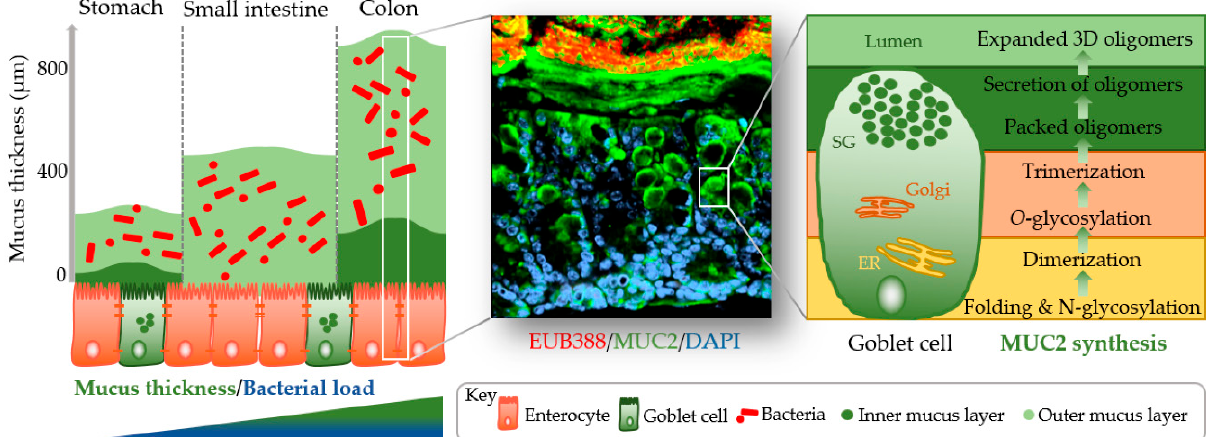
Figure 1. Simplified graphical illustration of mucus thickness and synthesis. Mucus thickness and bacterial load increase from the proximal to the distal end of the gastrointestinal tract. Shown in the left panel are mucus thickness values for the stomach, small intestine, and colon. While the stomach and colon have clearly defined inner and outer mucus layers, the small intestine does not. Shown in the middle panel is a cross-section of a wild-type mouse colon after fluorescent in situ hybridization using a bacterial EUB388 probe (red) and anti-MUC2 staining (green). Nuclei are counterstained with DAPI (blue). Bacteria are clearly confined to the outer mucus layer, with the stratified inner layer being devoid of bacteria. The right panel represents a simplified depiction of MUC2 synthesis in the corresponding goblet cell compartments (ER, endoplasmic reticulum; Golgi, Golgi apparatus; SG, secretory granules).